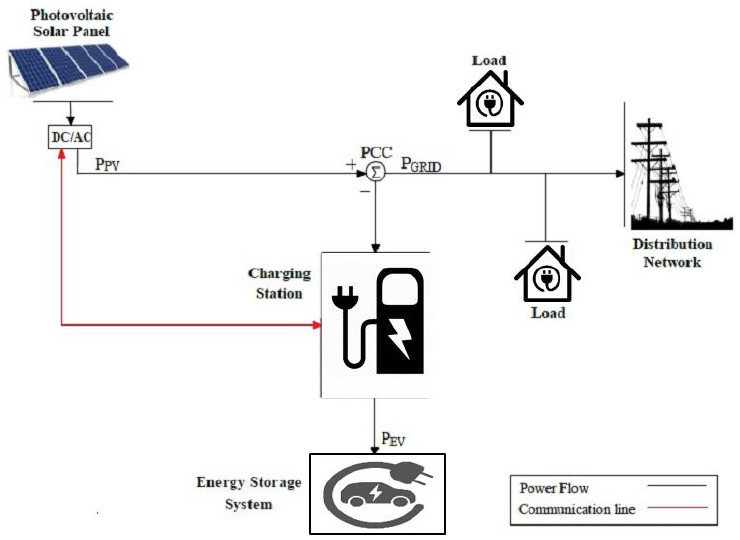
Figure 2. Energy management